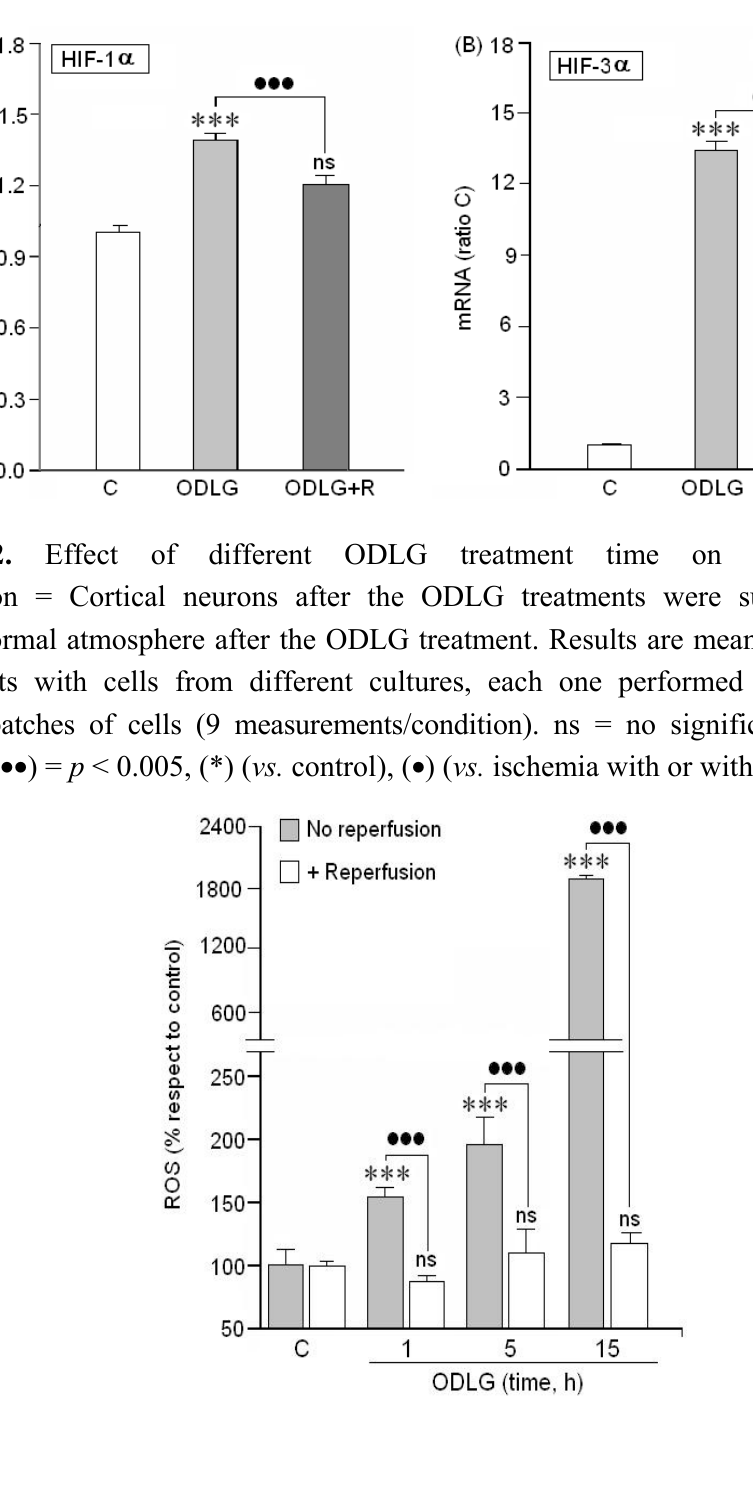
Figure 1. Induction of HIF 1 α ( A ) and HIF-3 α gene expression ( B ) in cortical neurons after exposure to ODLG conditions during 24 h. C = control, ODLG = 24 h treatment, ODLG + R = 24 h treatment followed by 24 h reperfusion. ns = no significant ( vs. control) (***) or ( ••• ) = p < 0.005; (***) = vs. control; ( ••• ) = vs. ischemia with or without reperfusion.